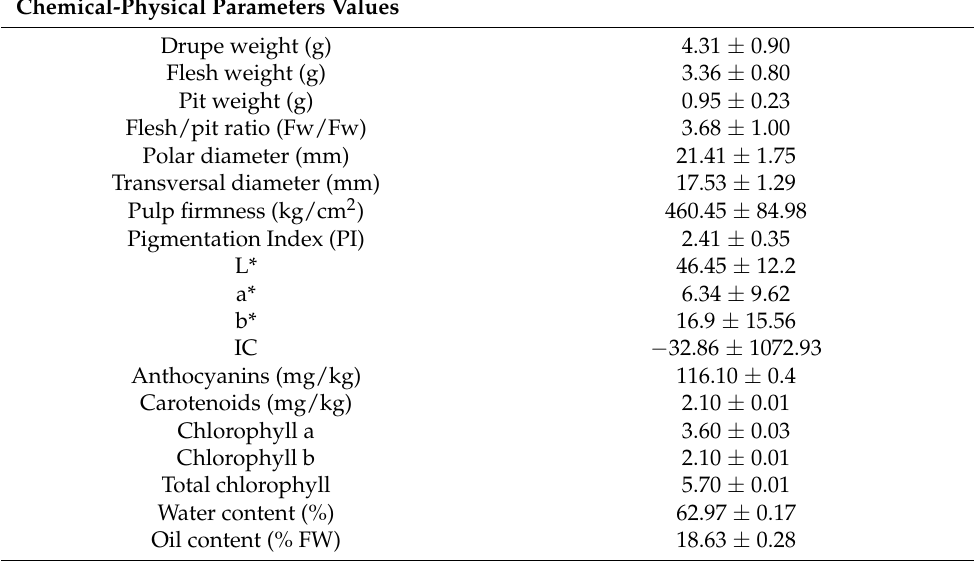
Table 1. Physical, chemical and chromatic parameters at harvest of the drupes of cultivar “Oliva Bianca”. The morphological parameters of fruit are reported as means ± SD of 100 different replicates ( n = 100), while the analytical parameters are reported as means ± SD of three different replicates ( n = 3).